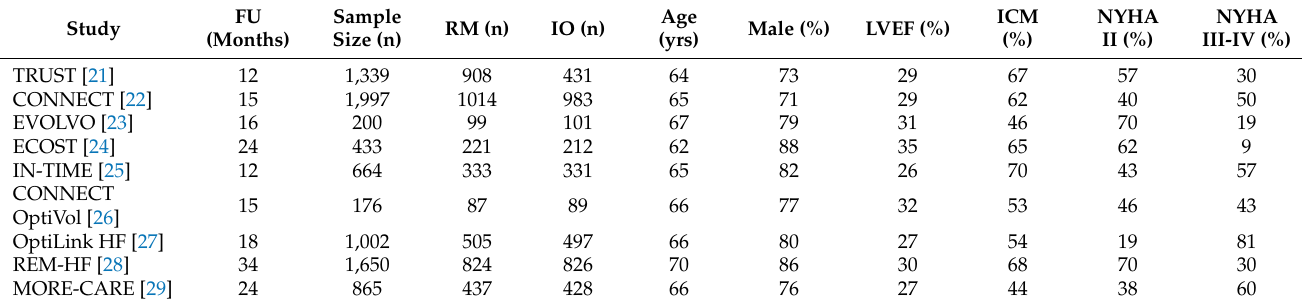
Table 1. Baseline characteristics of patients included in randomized clinical trials.